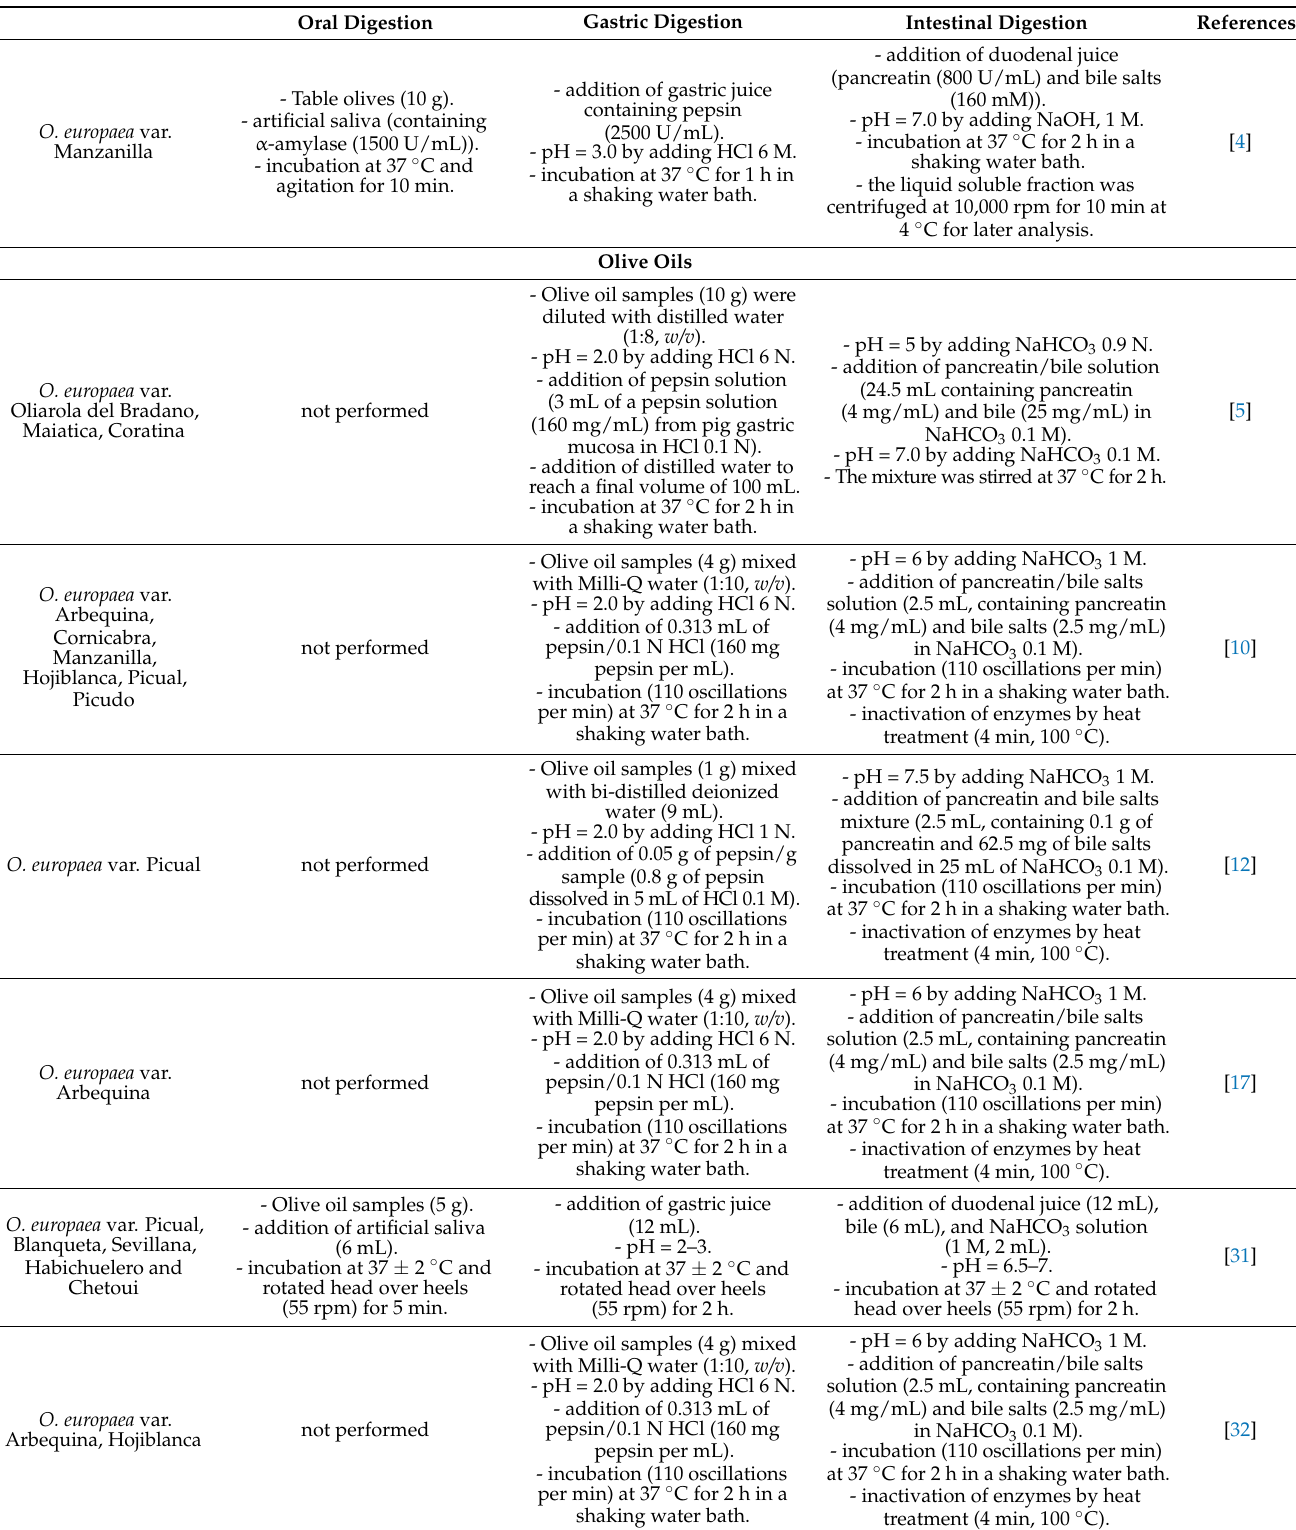
- Table olives (10 g). - artificial saliva (containing α -amylase (1500 U/mL)). - incubation at 37 ◦ C and agitation for 10